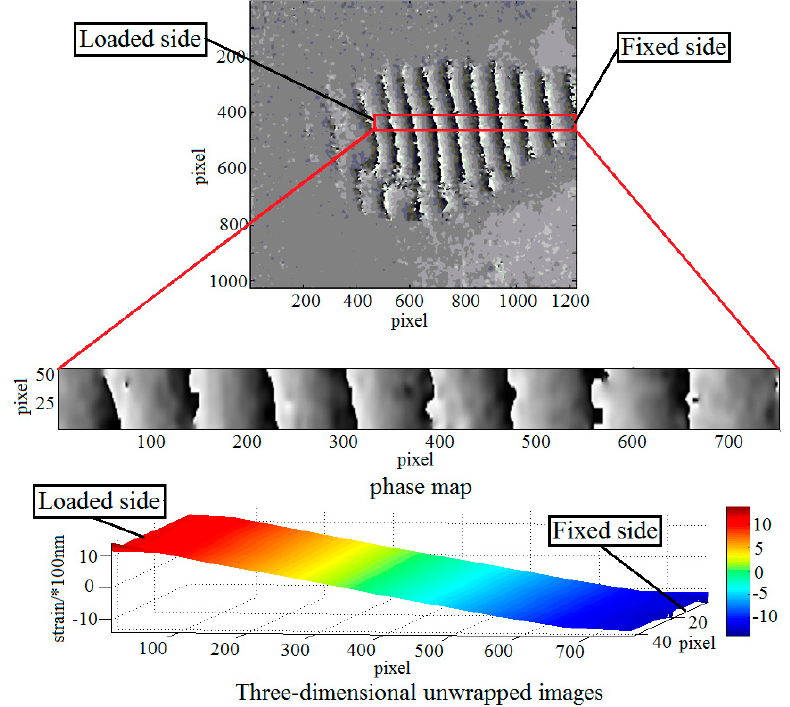
Figure 9. The quantitative loading experiment.